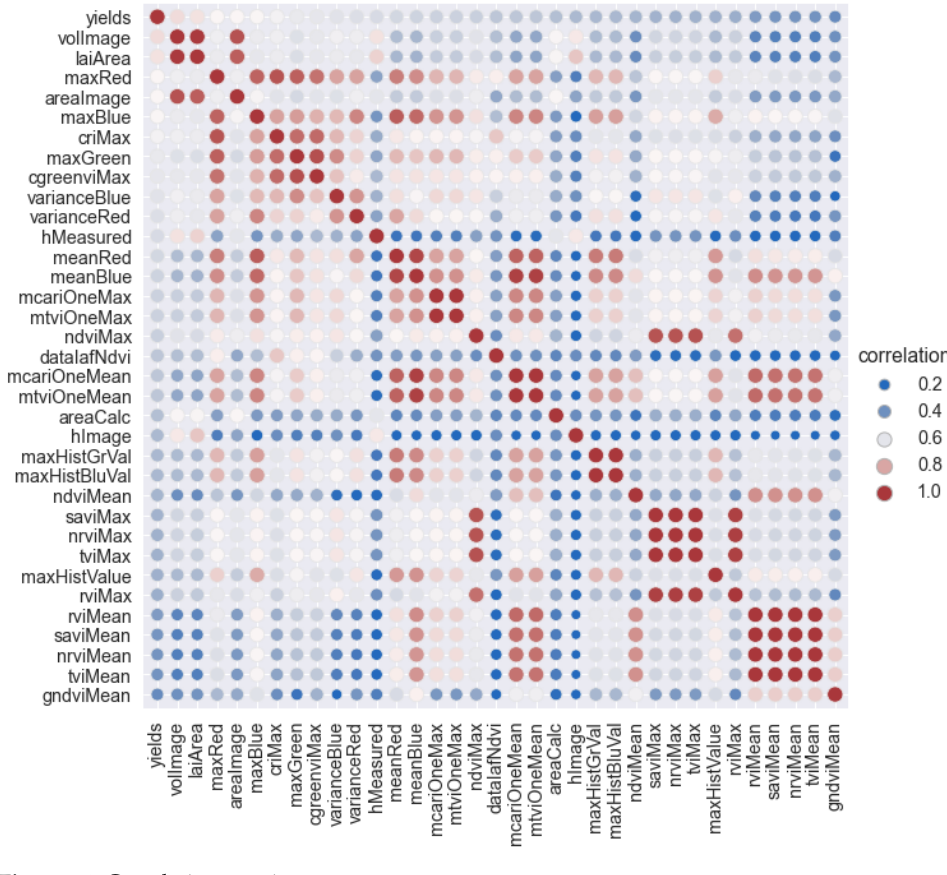
Figure 14. Correlation